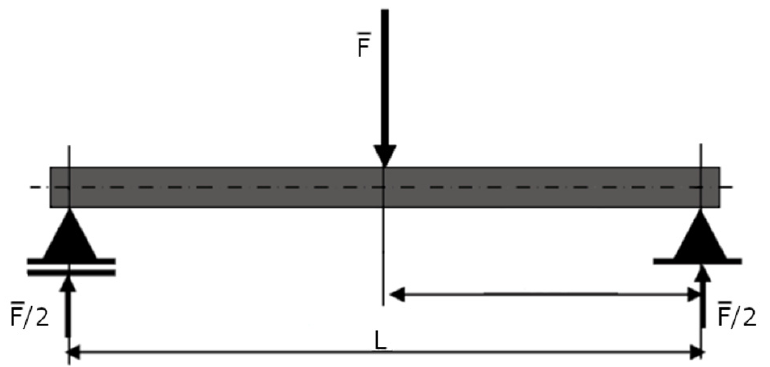
Figure 1. Scheme of the three ‐ point bend test.